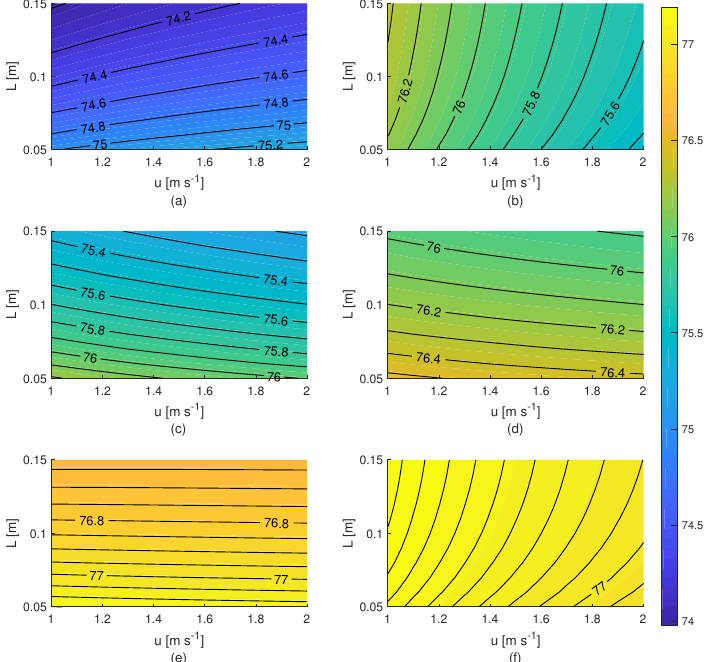
Figure A7. Temperature-Humidity Index (THI) at outlet pad air conditions as a function of inlet air velocity ( u ) and pad thickness ( L ) for the pad materials studied. ( a ) Cellulose. ( b ) Small coconut shell (7.9–12.7 mm). ( c ) Big coconut shell (12.7–19.0 mm). ( d ) Burnt-clay bricks (12.7–19.0 mm). ( e ) Small pumice stones (34.9–45.0 mm). ( f ) Big pumice stones (45.0–55.5 mm).